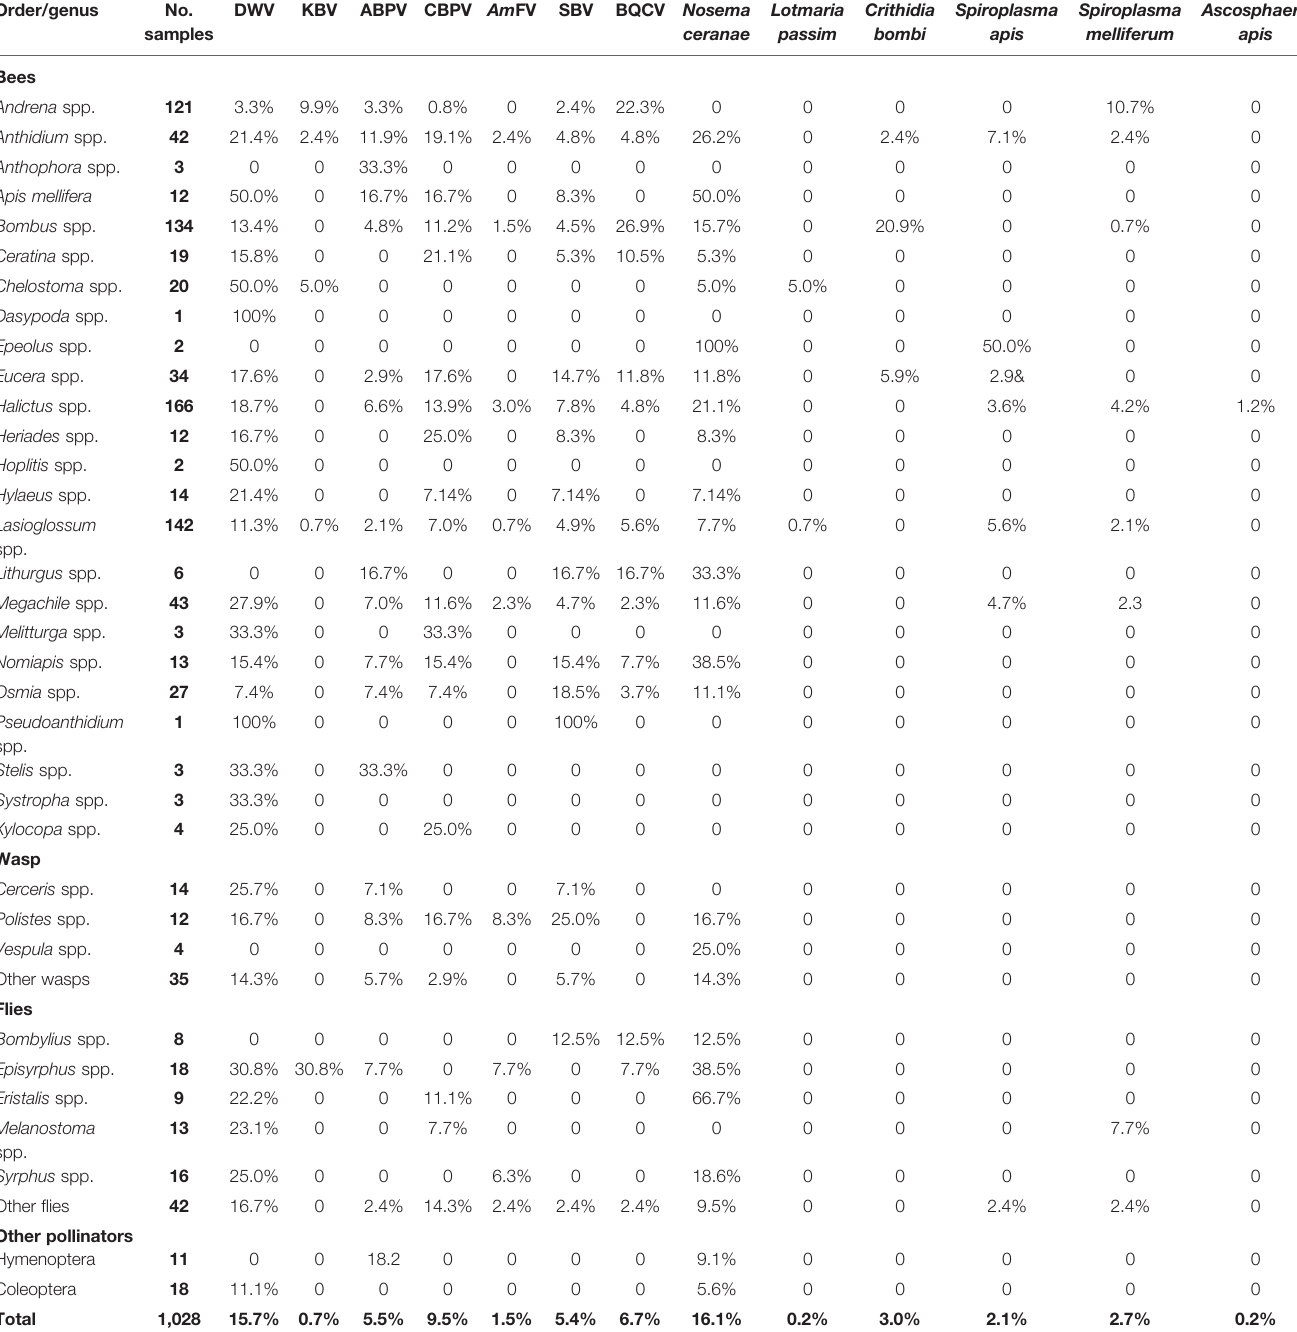
TABLE 4 | Prevalence of the positive samples per order or genus (ranked in alphabetical order) for the investigated pathogens (complete data are provided in Table S1 ). Order/genus No. samples